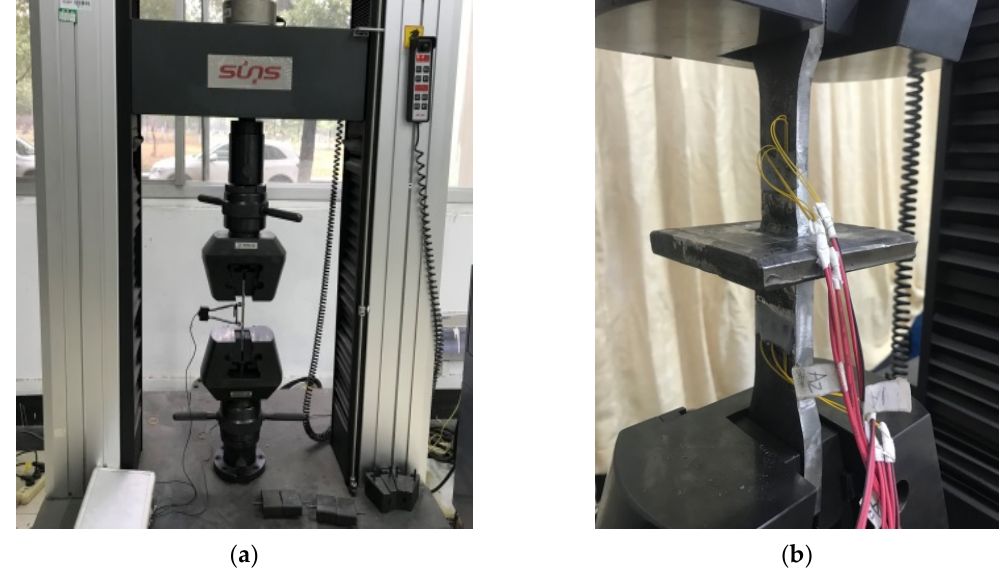
Figure 3. Test setup: ( a ) overview; ( b ) specimen on the test machine.